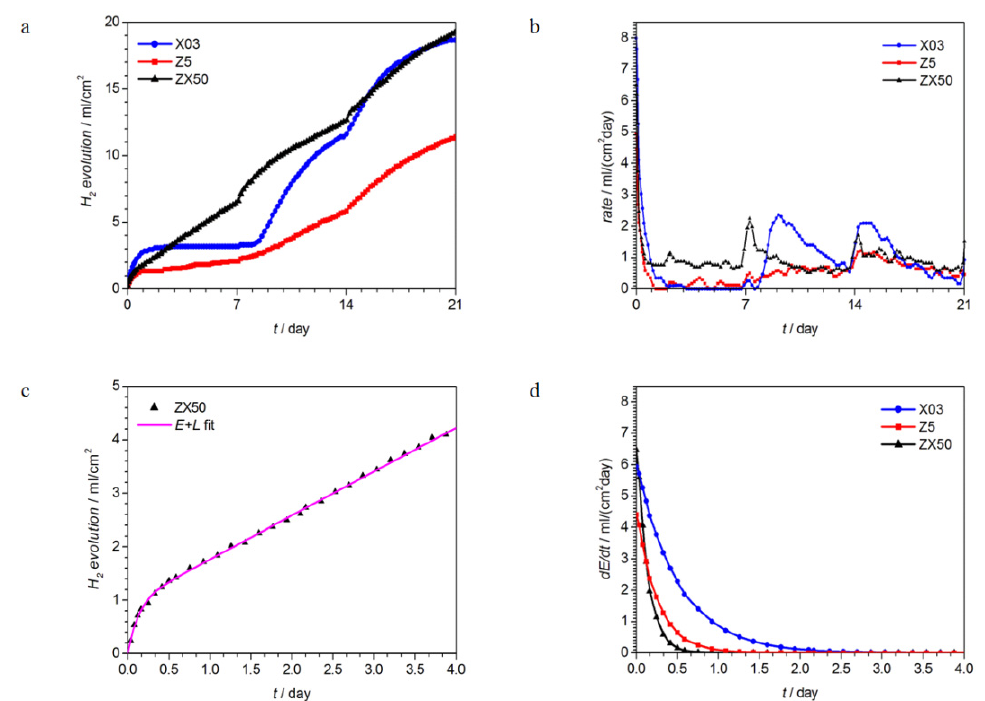
Figure 4. H 2 evolution ( a ), the corrosion rates ( b ), H 2 evolution fitted by E + L ( c ) and the rates for the exponential contribution ( d ).